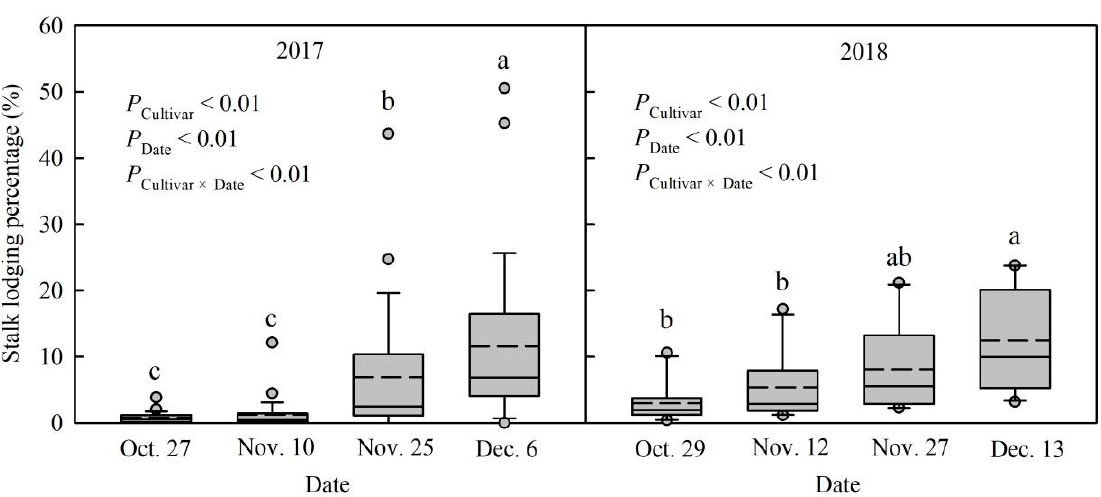
Figure 4. Natural stalk lodging rate of different maize cultivars after physiological maturity. The main box designates IQR containing 50% samples in a Box-whisker Plot. The two sidelines indicate the reasonable sample border in Tukey method. The solid line in box locates the median sample. The hidden line indicates the average value. The circle indicates the outlier. Different lowercase letters indicate significant differences ( p < 0.05) among the harvest